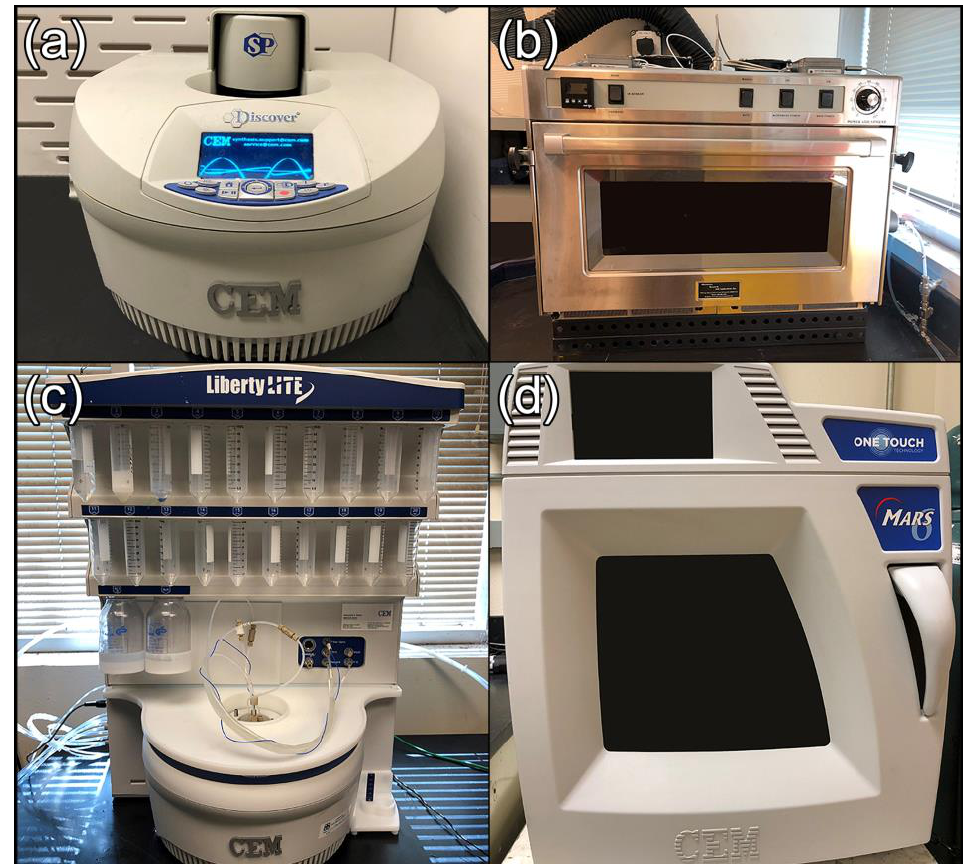
Figure 2. Microwave reactors with advanced design features: ( a ) single-mode cavity CEM Discover SP; ( b ) Microwave Research and Applications BP-210 processing MW with reaction temperatures up to 1800 °C; ( c ) CEM Liberty Blue with critical reagent delivery system; ( d ) CEM MARS6 with high-throughput capacity and fiber optic temperature sensor.